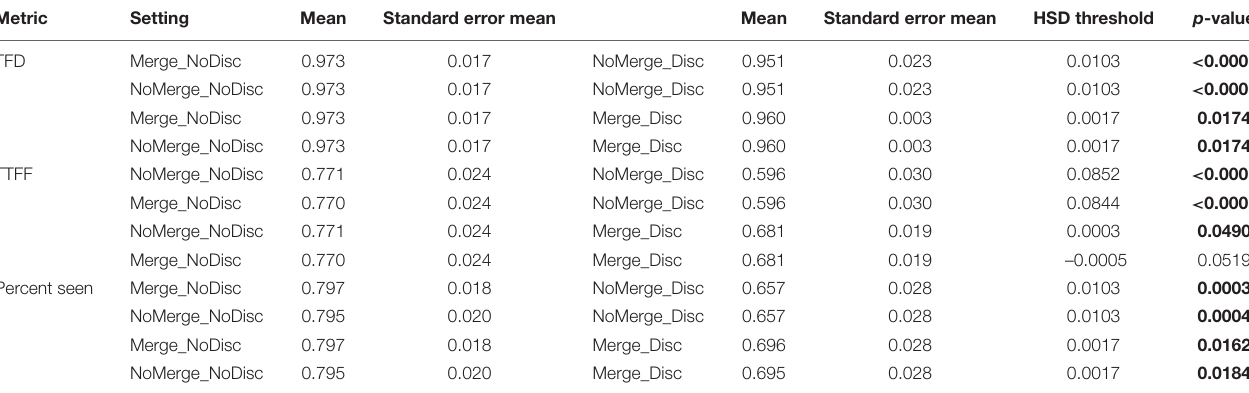
TABLE 3 | R 2 of TFD, TTFF, and Percent Seen – Mean values and standard errors of settings of merging adjacent fixations and discarding short fixations, and significantly different pairwise comparisons based on Tukey–Kramer HSD